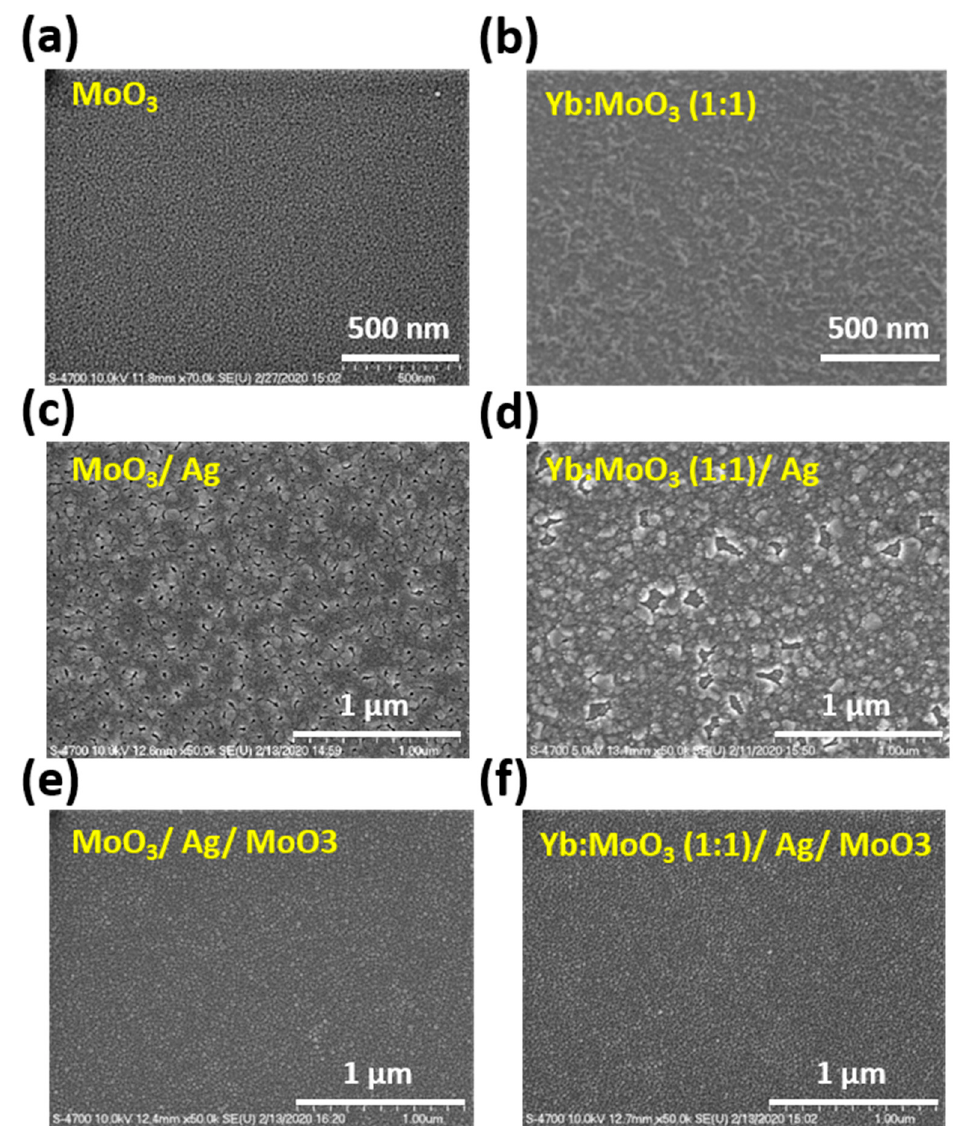
Figure 2. Scanning electron microscopy (SEM) images of the DMD surface morphology on glass substrate. ( a ) MoO 3 (5 nm), ( b ) MoO 3 (5 nm)/Ag (10 nm), ( c ) MoO 3 (5 nm)/Ag (10 nm)/MoO 3 (32 nm), ( d ) Yb:MoO 3 (1:1–5 nm), ( e ) Yb:MoO 3 (1:1–5 nm)/Ag (10 nm), ( f ) Yb:MoO 3 (1:1–5 nm)/Ag (10 nm)/MoO 3 (32 nm).